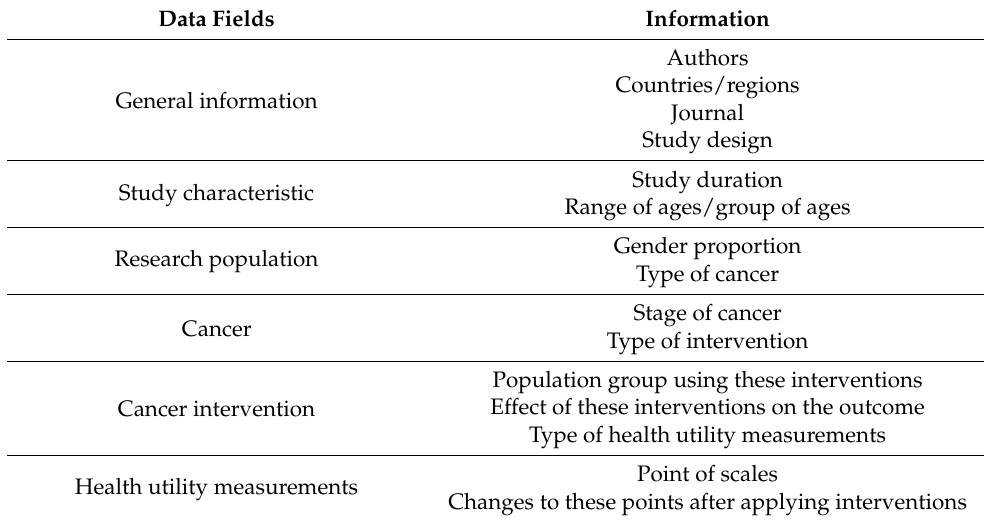
Table 1. Data extraction